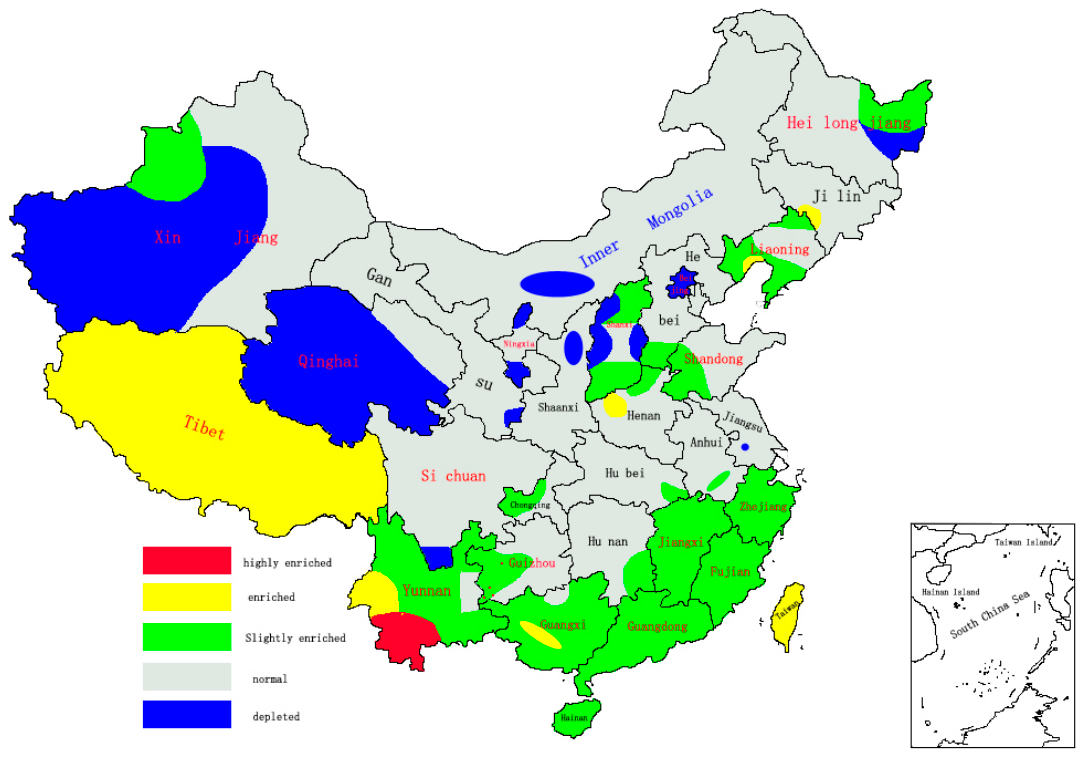
Figure 1. Arsenic distribution in Chinese coals by provinces.